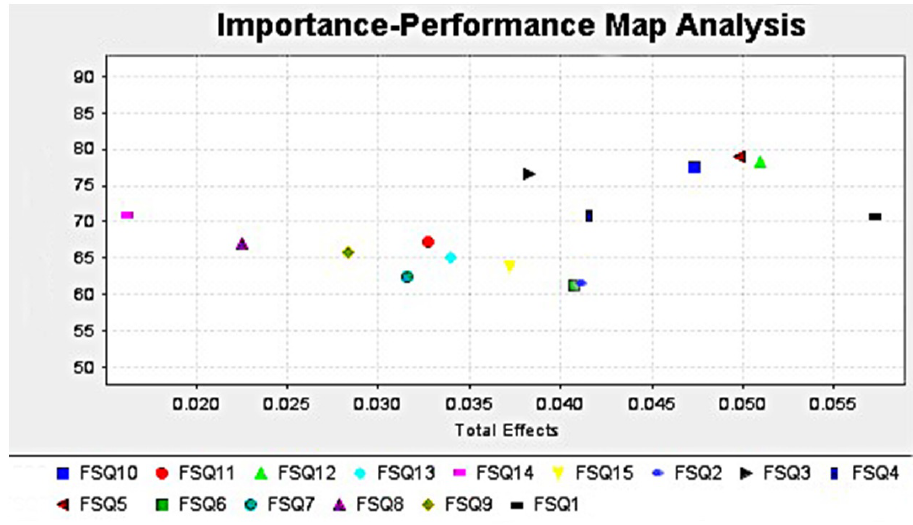
Figure 3. IPMA of brand engagement.